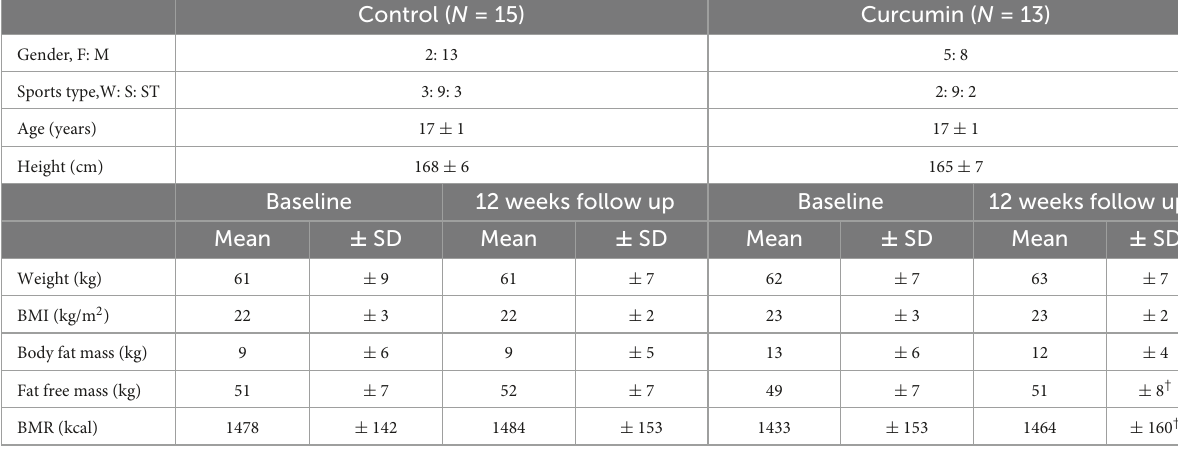
TABLE 1 Demographics and body composition data of the